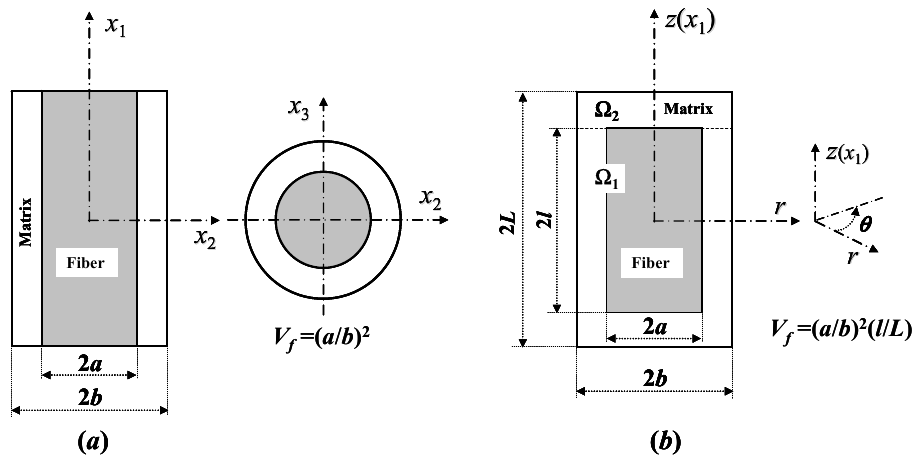
Figure 3. RVEs of ( a ) continuous fiber, and ( b ) short fiber reinforced composites. Using a bridging equation, the matrix with those of the fiber, one obtains [17]